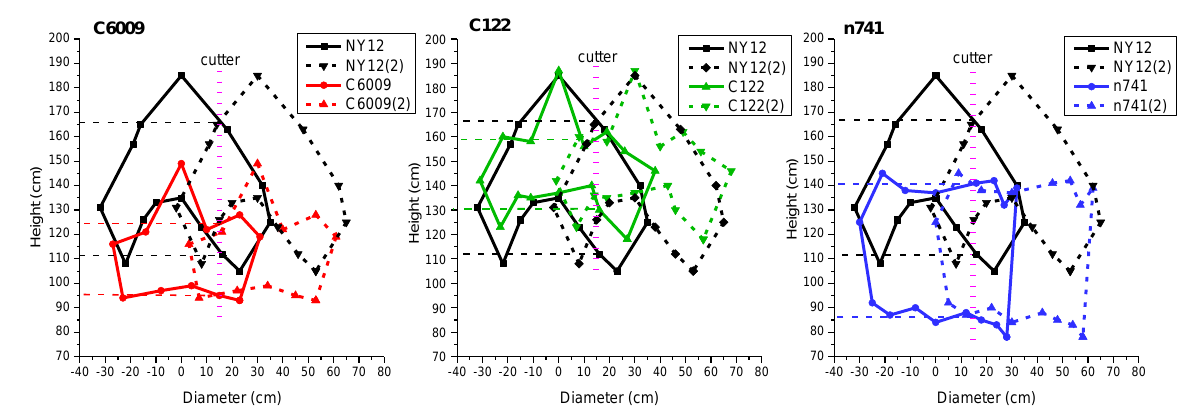
Figure 3. Comparison of the shapes of the pod layers of C6009, C122, and n741 with the commercial variety NY12. The horizontal axis represents the coordinate of the pod layer, where the value “0” corresponds to the main inflorescence of rape; for n741, zero corresponds to the middle position of the whole pod layer because it had more than one main inflorescence. The vertical axis represents the height of the pod layer above the ground. The dashed line (2) represents the pod layer of adjacent rape plants with a planting space of 30 cm. The pink dash-dotted line corresponds to the vertical cutter and intersects with the pod layer, and the corresponding longitudinal height range of the left dash-dotted line at its intersection is the height of the cutting pod layer of each variety at harvest.